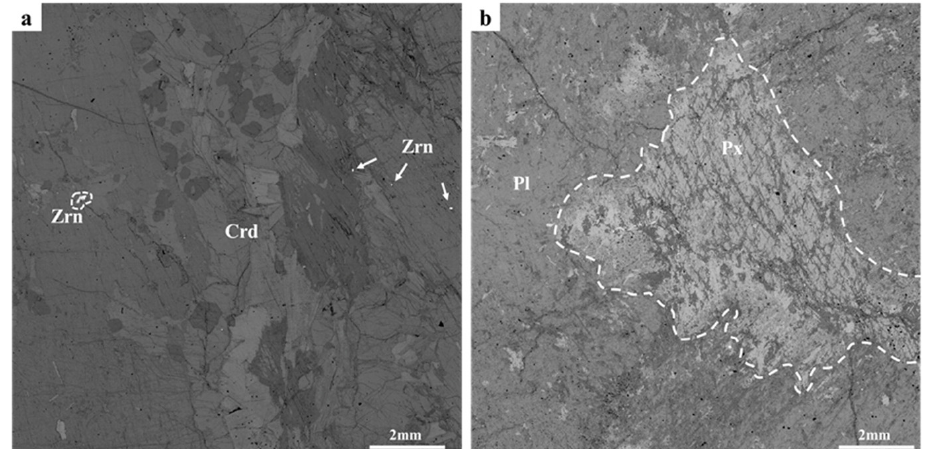
Figure 1. BSE images of ( a ) cordierite and ( b ) gabbro. Cordierite mainly consisted of panel/grained cordierite ( ～ 98 vol.%) with a small amount of grained zircon (~2 vol.%). Gabbro was characterized by the gabbro texture, and it was mainly composed of pyroxene vein (~30 vol.%) and plagioclase phenocryst (~70 vol.%). Crd, cordierite; Zrn, zircon; Pl, plagioclase; Px, pyroxene.